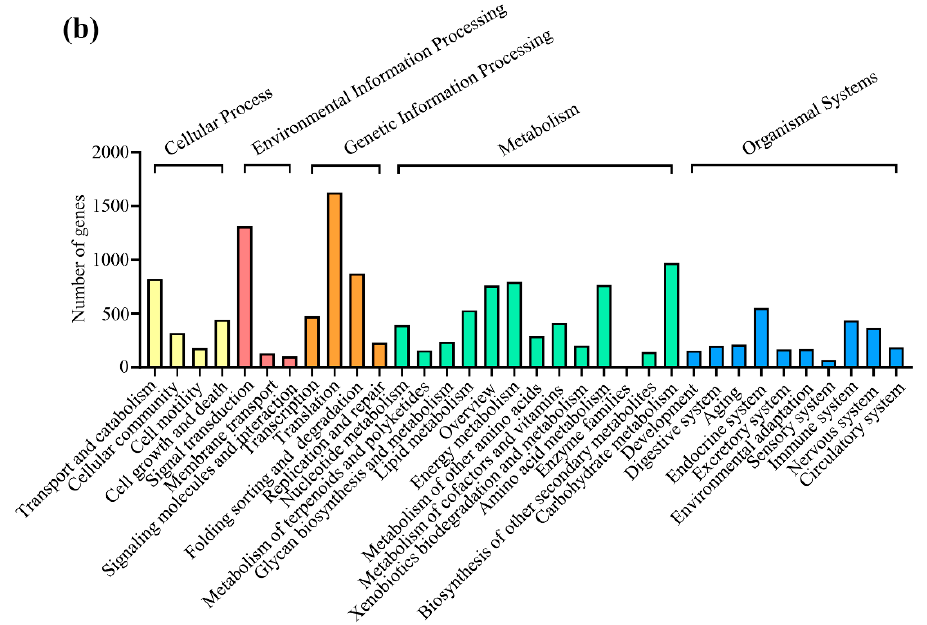
Figure 2. Functional classification of the unigenes. ( a ) The number of annotated unigenes in five public databases. ( b ) KEGG classifications of unigenes.